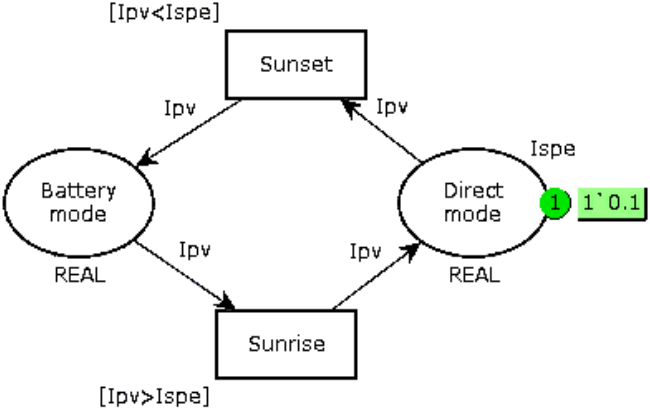
Figure 4. PMU operating modes according to the current coming from the photovoltaic panel.